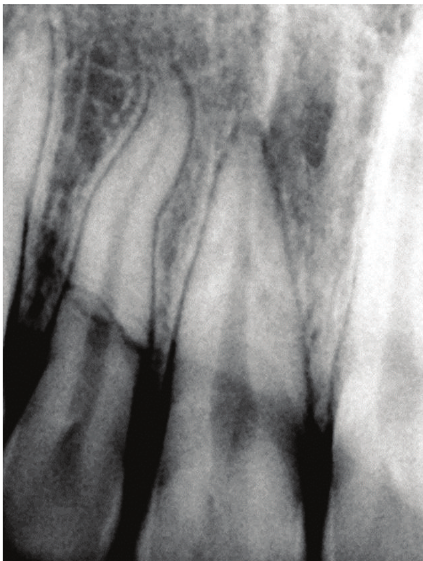
Figure 14: Diagnostic radiograph.